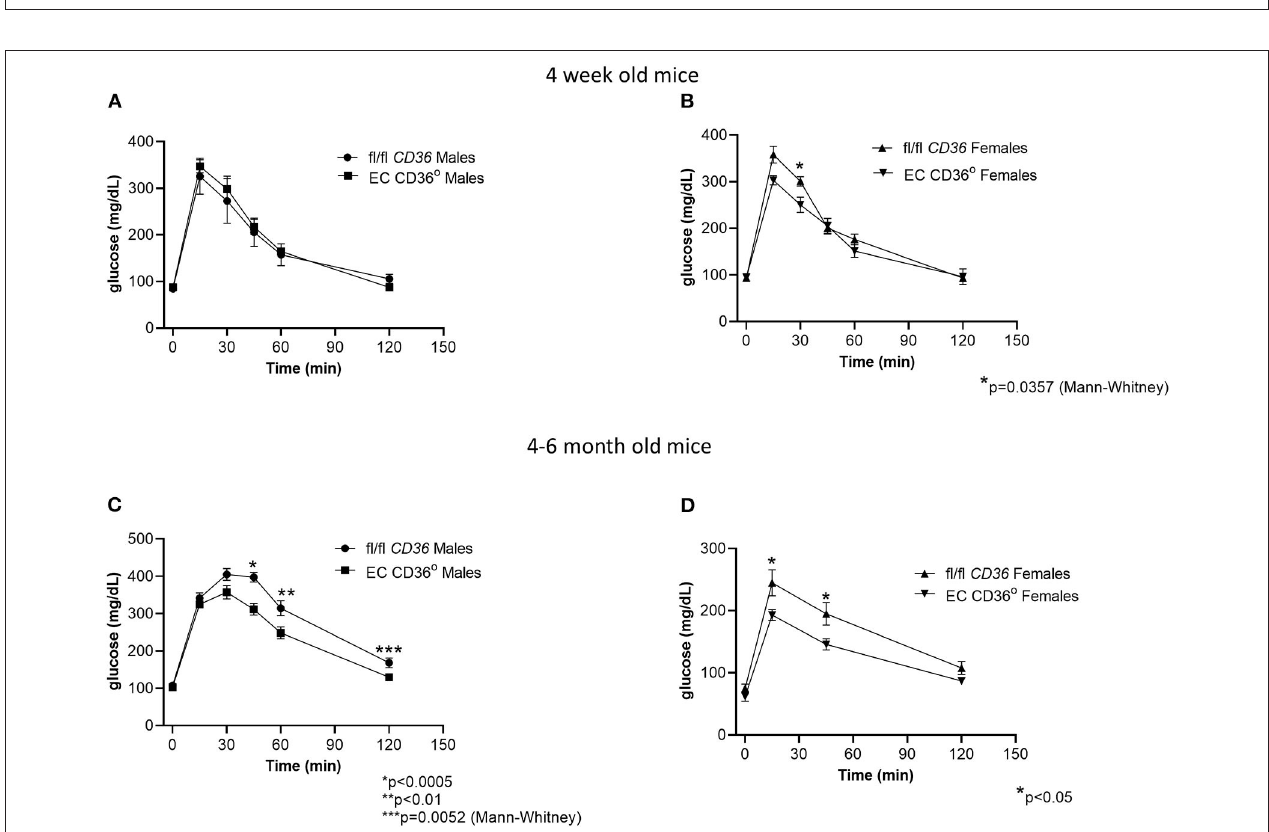
FIGURE 2 | Glucose tolerance testing of normal chow-fed EC CD36 ◦ and fl/fl CD36 mice. (A) Four-week-old male mice showed no differences (fl/fl CD36 , n = 3; EC CD36 ◦ , n = 6). (B) Four-week-old female mice showed a significant difference at 30min; area under the curve (AUC) was not significant (fl/fl CD36 , n = 5; EC CD36 ◦